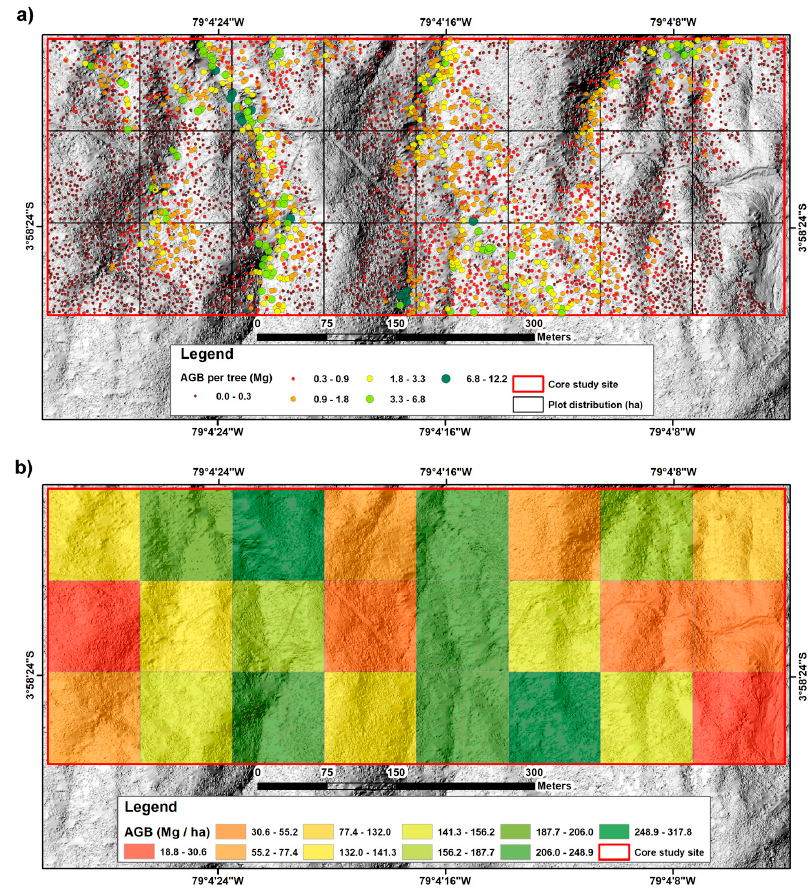
Figure 6. ( a ) Individual AGB values of the dominant trees detected in the core area; ( b ) Spatial distribution of AGB obtained from the RGB data.